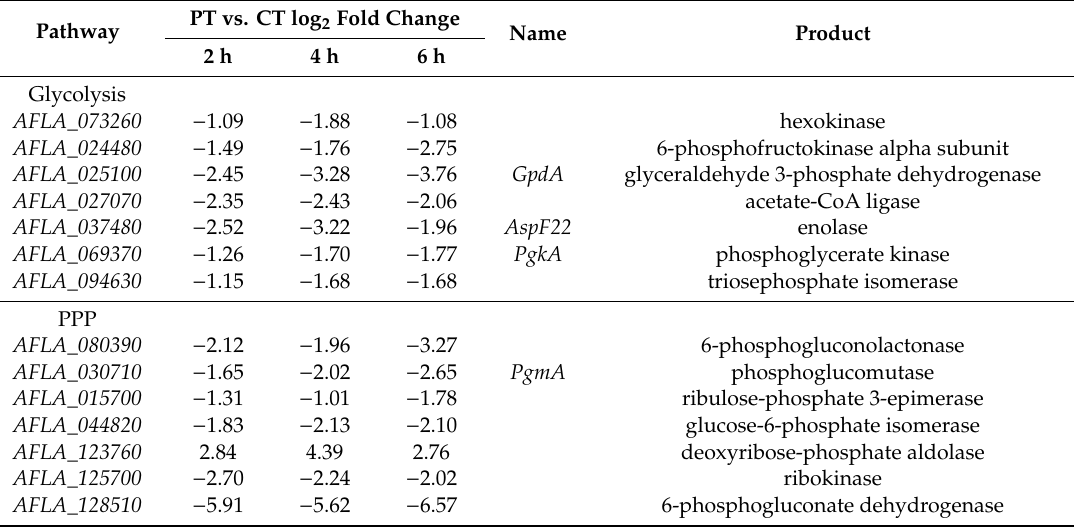
Table 3. Representative DEGs in di ff erent comparisons between each PAE treatment and control group.